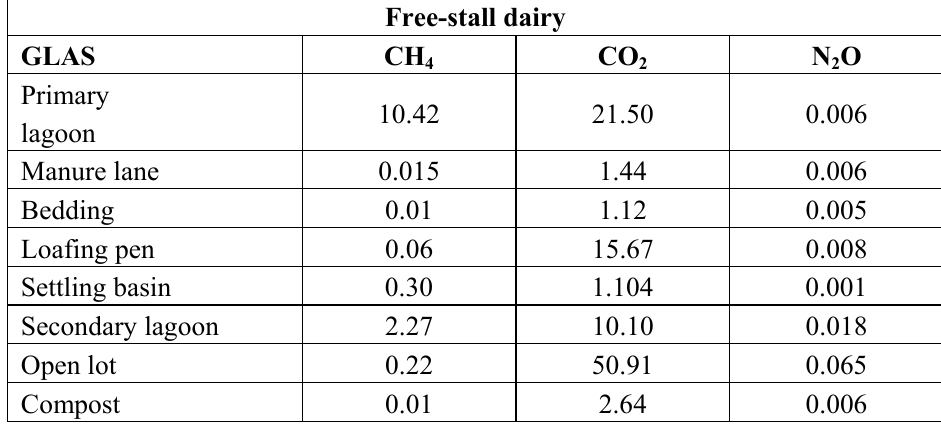
Table 6. Average overall uncertainties (g hd − 1 d − 1 ) estimated from different GLAS in dairy and feedyard